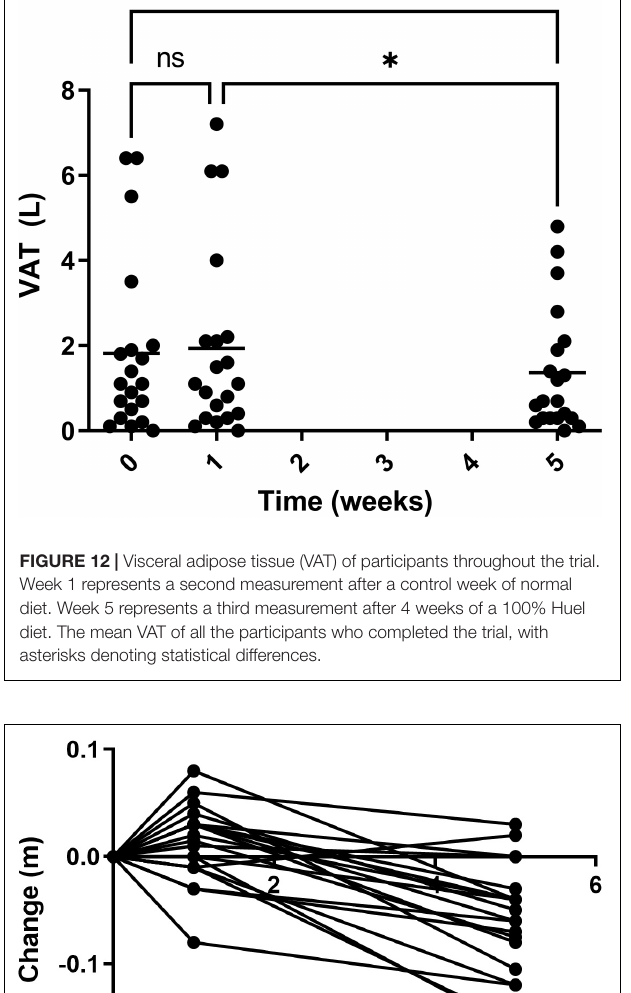
vitamin A uptake (29), then maintenance of the appropriate levels of vitamins A and E may have been